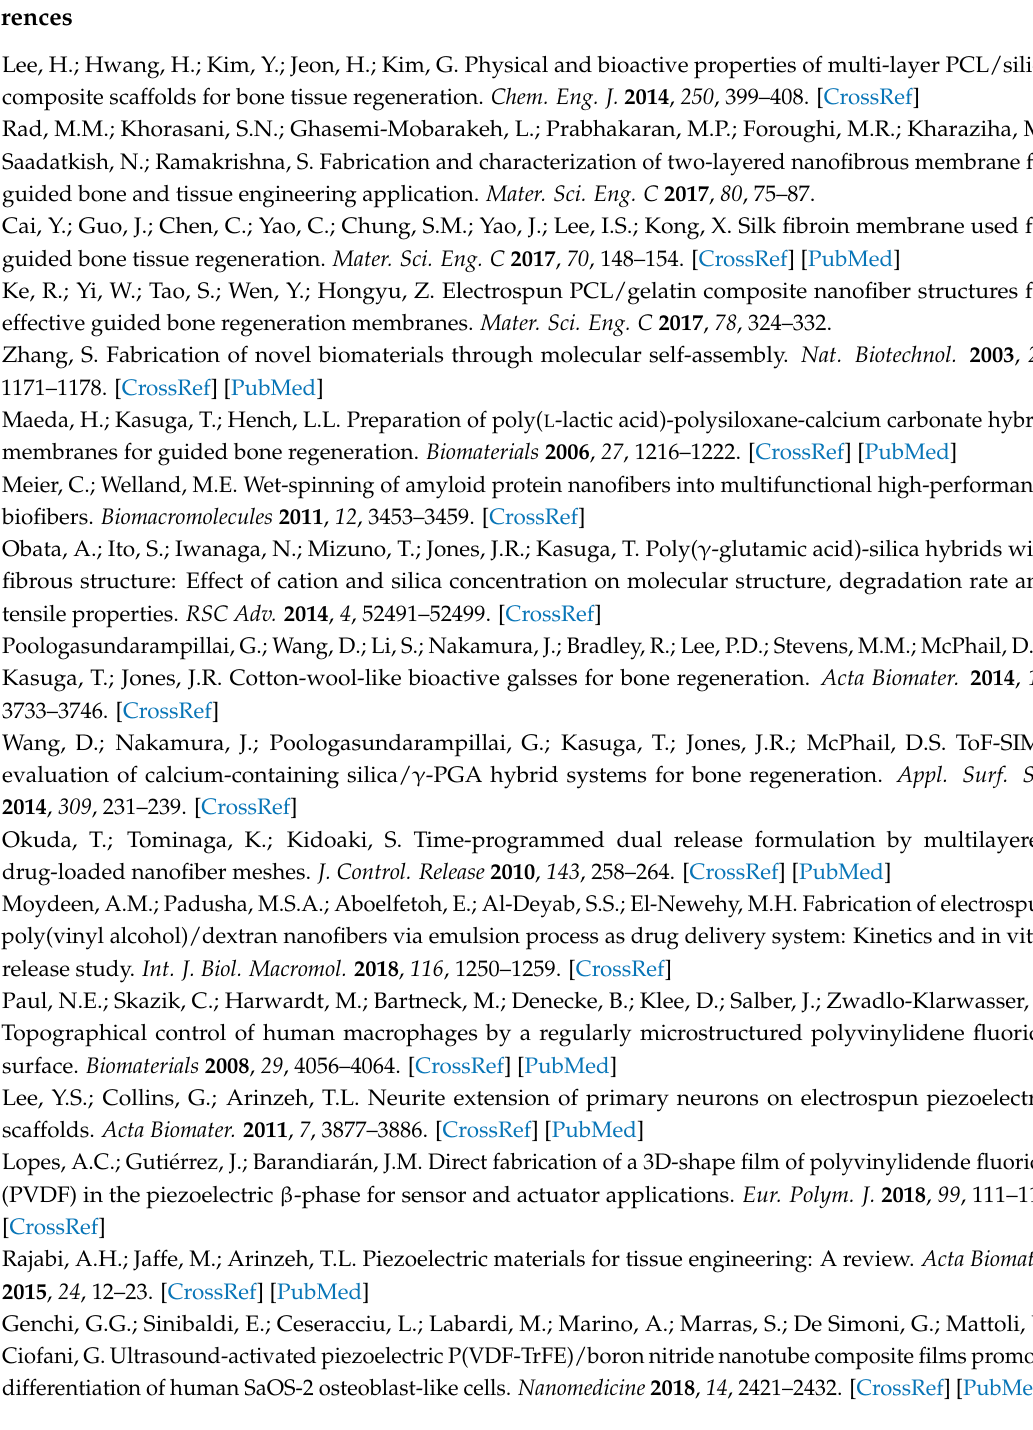
Figure S1: 1 H NMR spectrum of the POSS–EGCG conjugate. Figure S2: EDS Si-mapping images of the PVDF composite